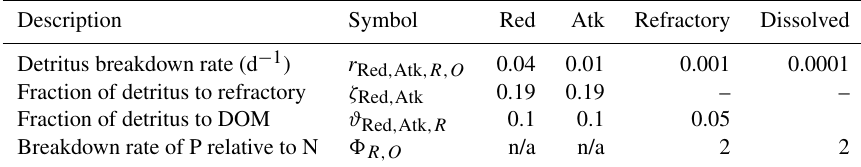
Table 39. Constants and parameter values used in the water column detritus remineralisation model. Red is the Redfield ratio (C : N : P = 106 : 16 : 1); Atk is the Atkinson ratio (C : N : P = 550 : 30 : 1); see Lønborg et al. (2017). n/a – not